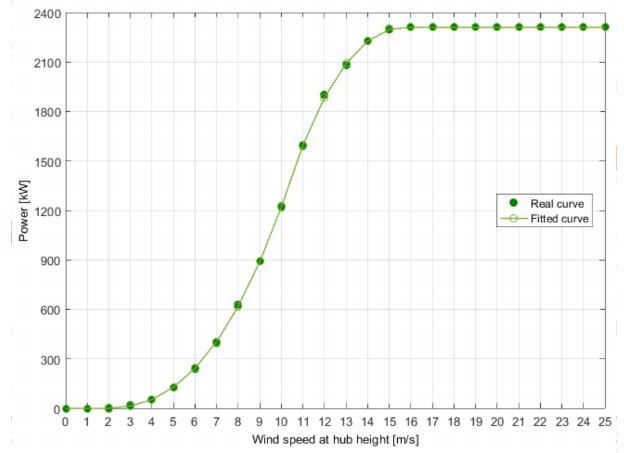
Figure 16. Wind turbine’s power